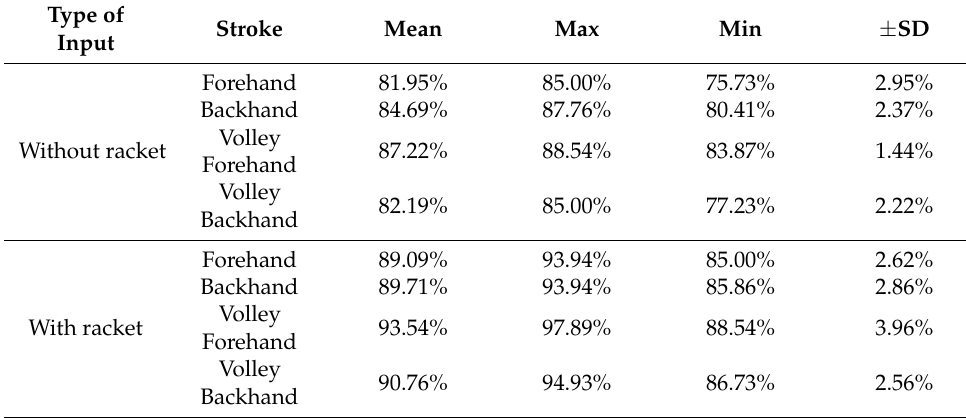
Table 4. Obtained Recall